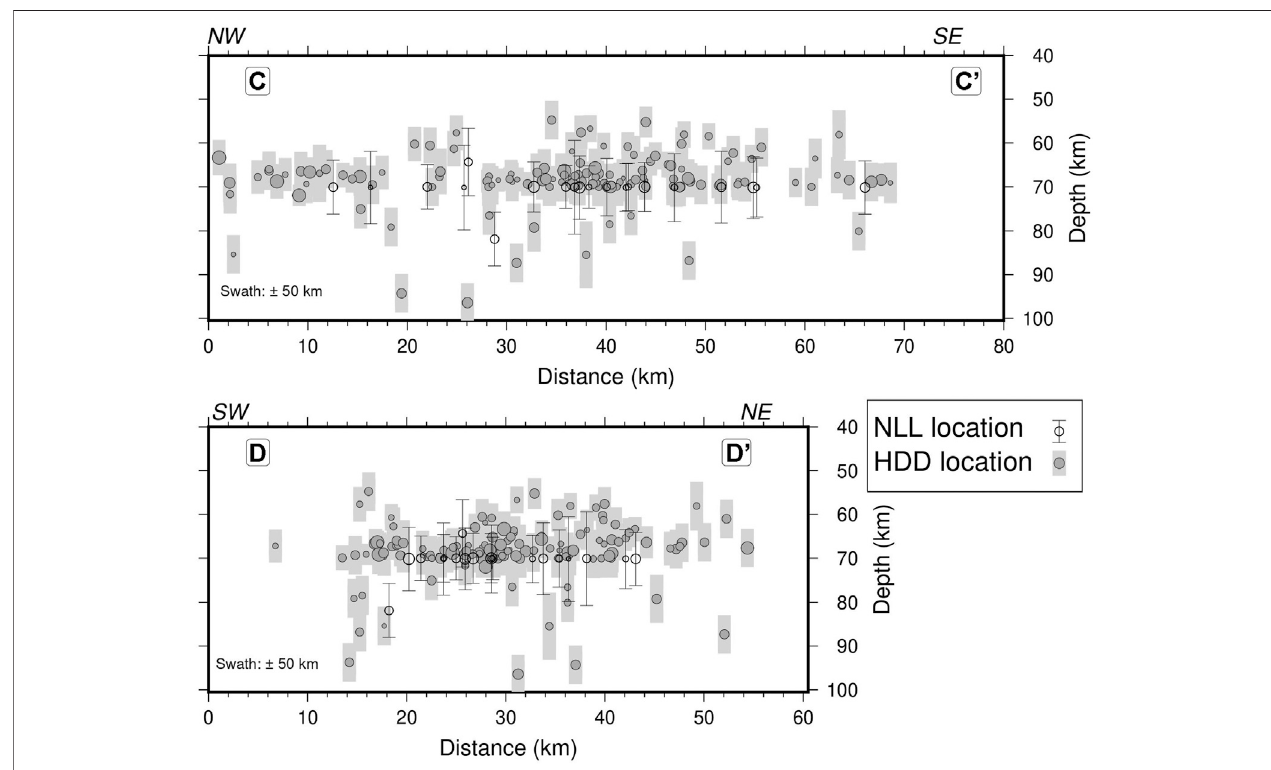
FIGURE 4 | Same as Figure 3 but for cross-sections C – C ′ and D – D ’ . Earthquakes within 50 km on either side of the cross-sections are shown. Note that cross- sections are vertically exaggerated and the size of the symbols are scaled to their respective magnitudes.